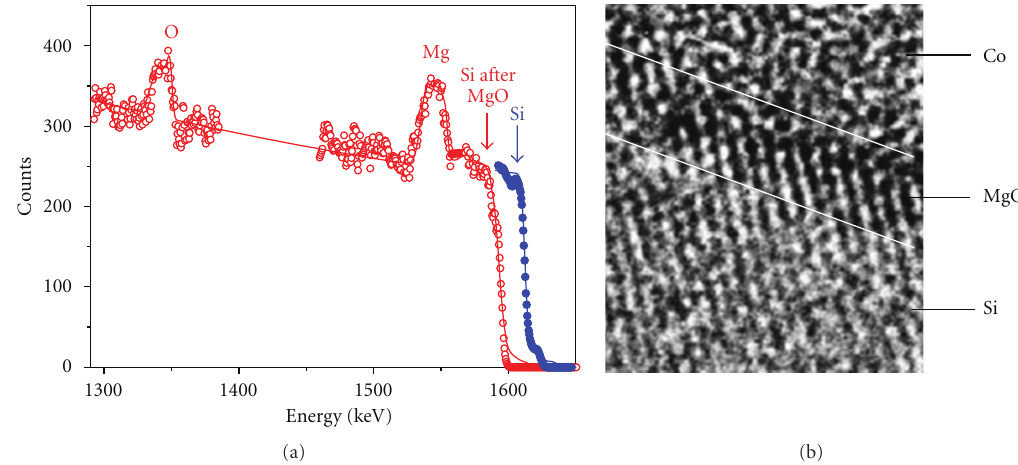
Figure 6: (a) HRBS spectra of a Si sample before and after MgO evaporation. Before evaporation: spectrum of the high-energy Si edge (solid circles) and RUMP simulation (solid line) of the clean Si. After MgO evaporation: spectrum of Si with Mg and O peaks of the 18.3 ML thick MgO film on top (open circles) and RUMP simulation (solid line) of the 18.3 ML thick MgO film as prepared on Si (100) surface. The spectrum shows that the MgO film is very uniform. Surplus oxygen at the surface of the MgO film is clearly visible. (b) HR-TEM cross- sectional micrograph of a Si (100)/MgO (18.3ML)/Co structure. The lines have been added at the interfaces to aid the eye in distinguishing the layers of small contrast di ff